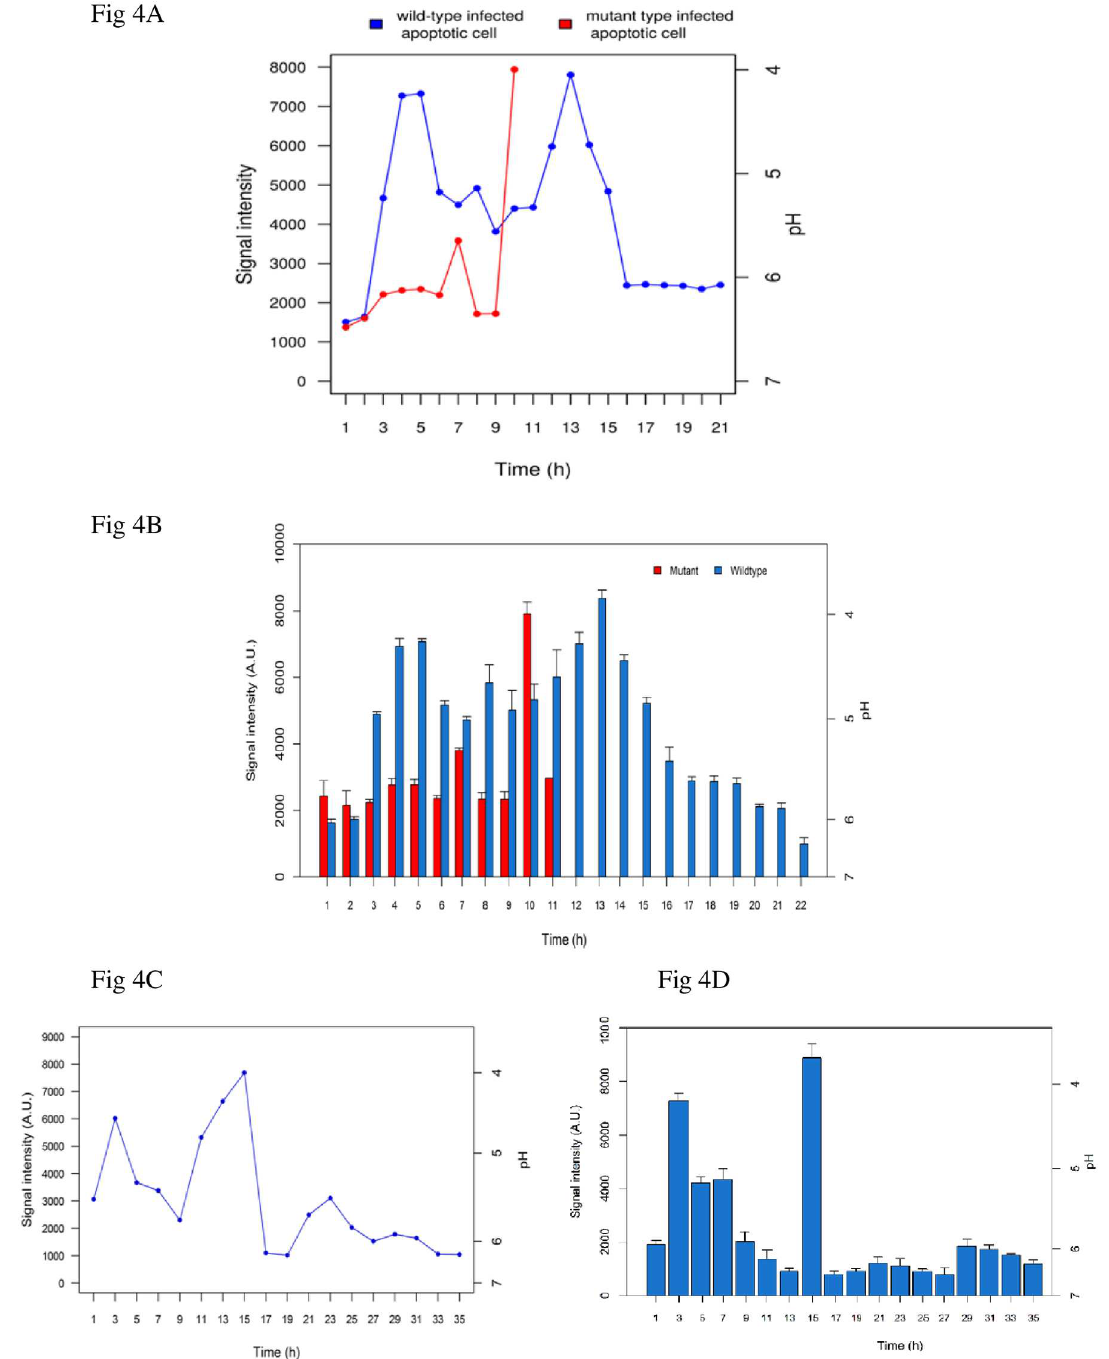
Fig 4. Kinetics of phagolysosomal pH upon infection. (A) Phagosomal pH in an apoptotic monocyte containinglabelled wild-typeconidia in comparisonto an apoptotic monocyte carrying pksP mutant conidia. (B) Data represent the mean + SD from three experiments. (C) Phagosomal pH in the survived apoptoticmonocyte infected with labelledwild-type conidia. (D) Data represent the mean + SD of cytosolic pH from three experiments.